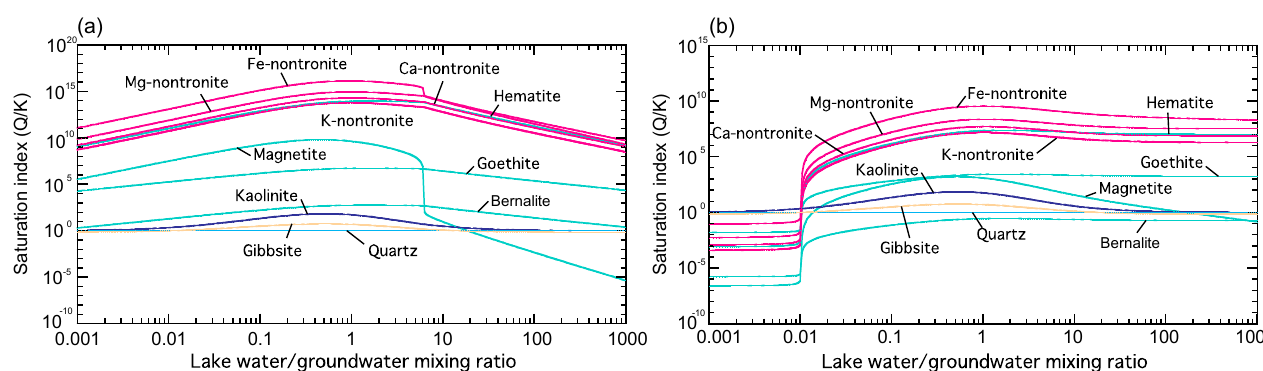
Figure A2. Mineral saturation indices when lake water and groundwater mixed under various lake water-to-groundwater mixing ratio at p O 2 of ( a ) 20 mbar and ( b ) 0.01 mbar.